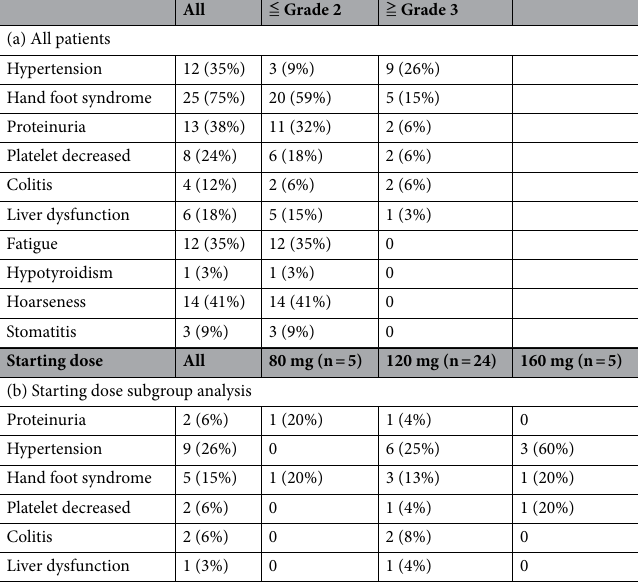
Table 2. Adverse events.